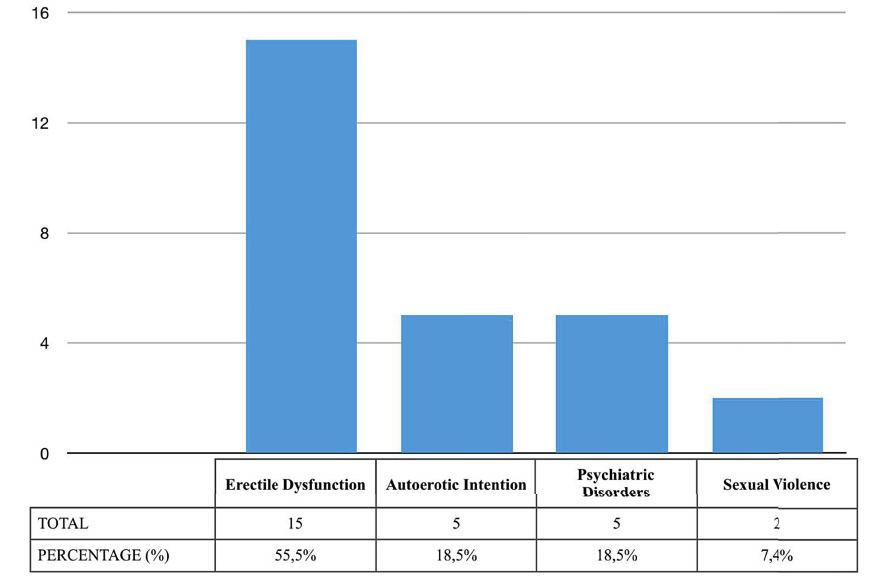
Figure 1 - Penile constrictor application according to its